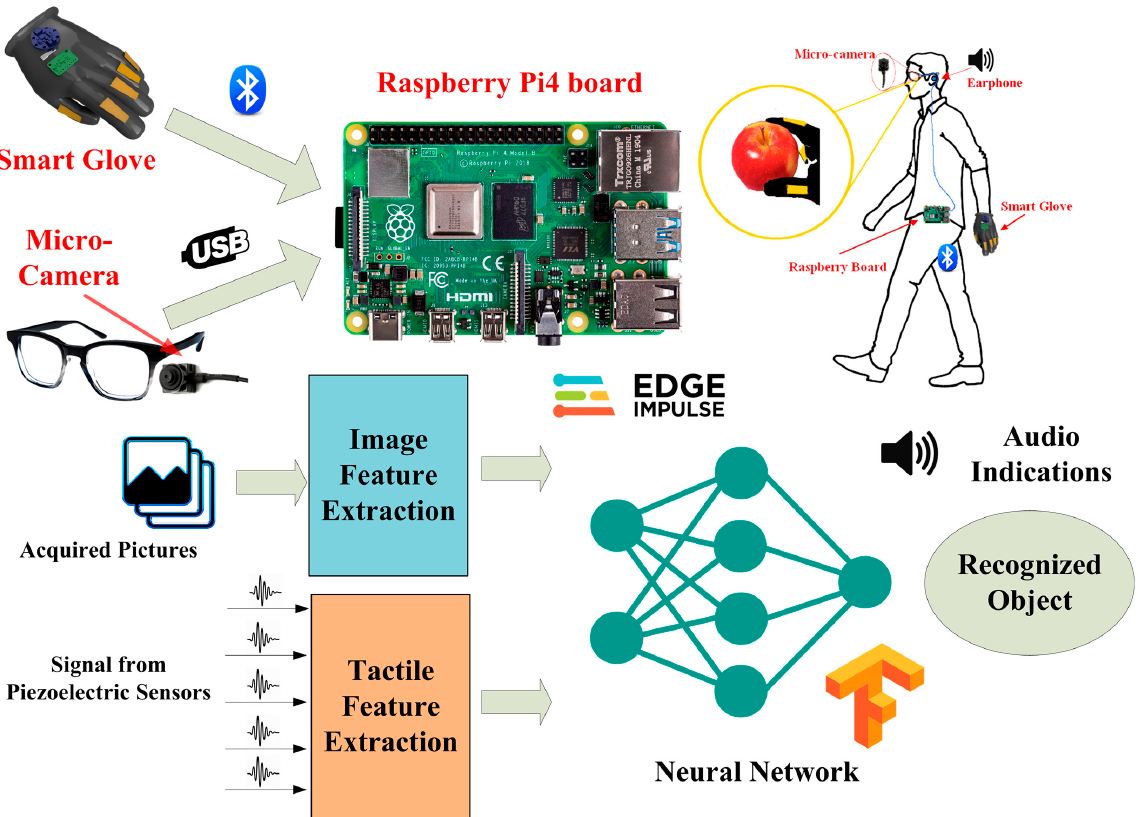
Figure 32. Graphical representation of the proposed combined tactile and image recognition sys- tem.